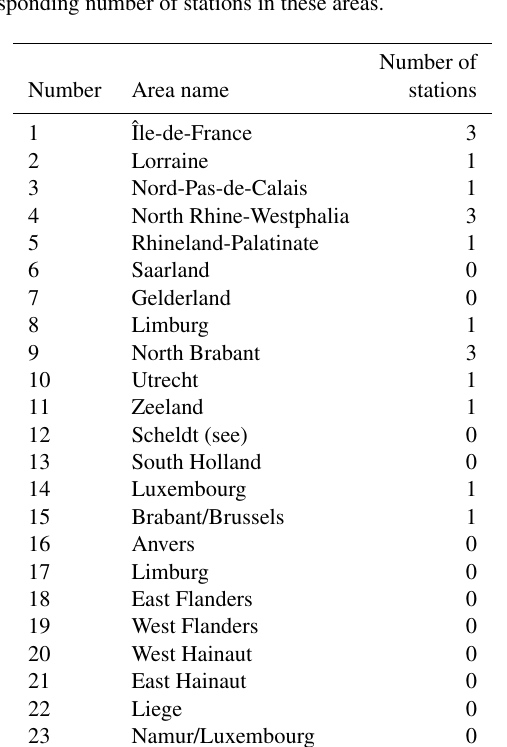
Table 1. List of areas of control in the main area of interest and corresponding number of stations in these